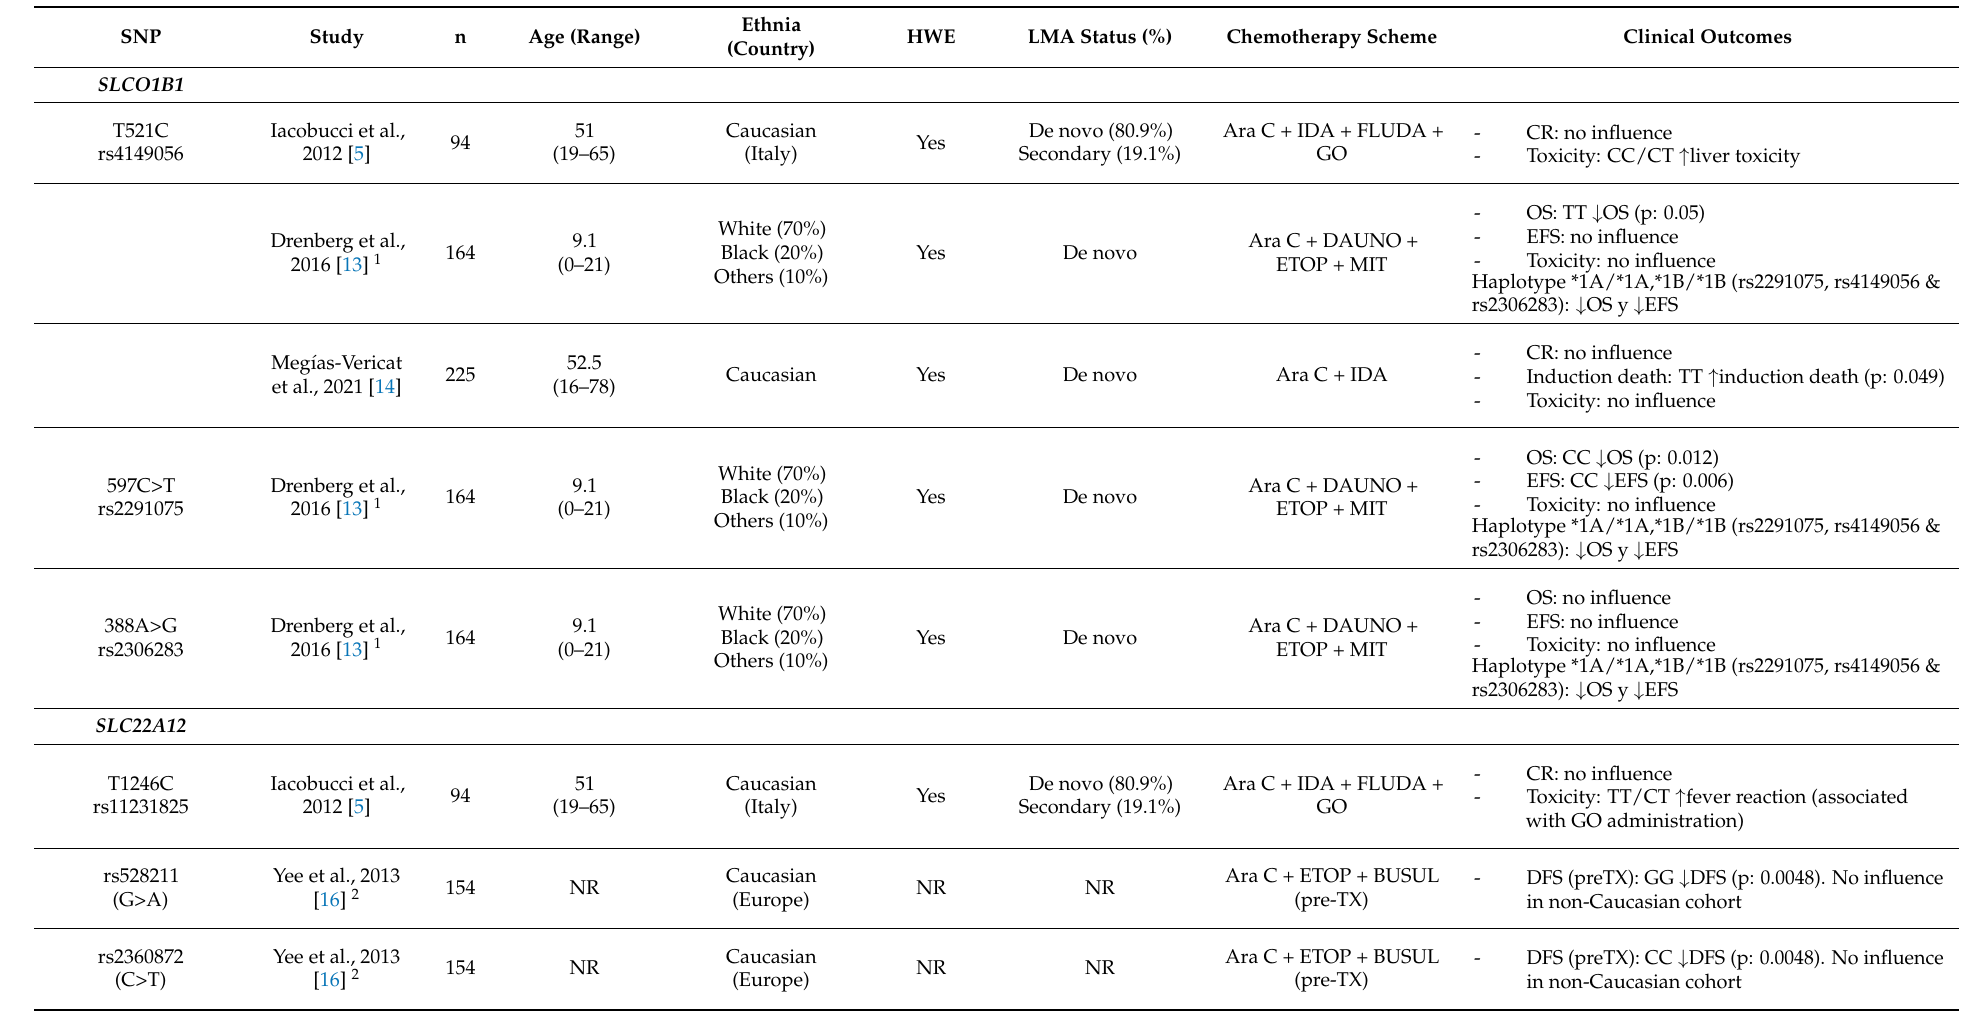
Table 1. Characteristics of the studies included in the systematic review for influx